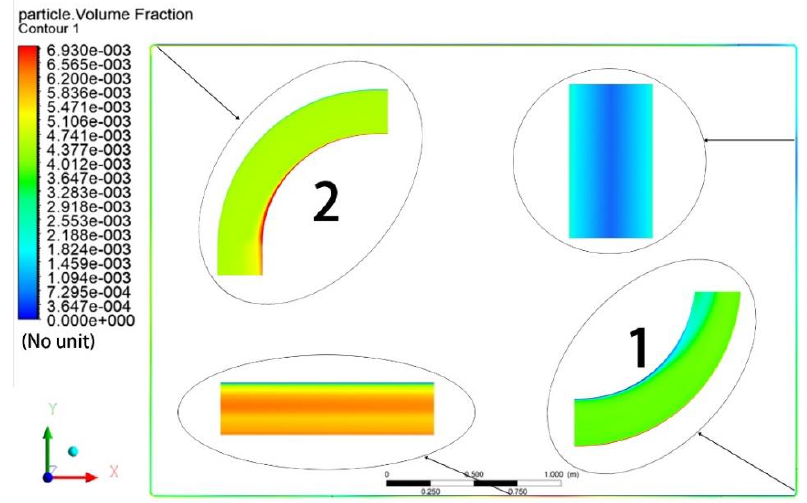
Figure 8. Particle concentration distribution of supercritical water natural circulation loop.